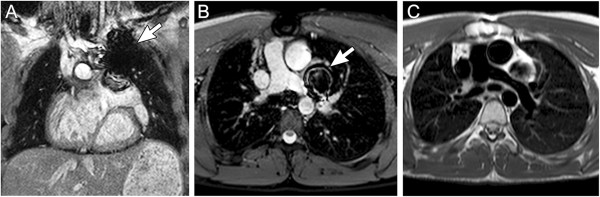
Stainless steel coil artifact. 17-year-old patient with dextrocardia, double-outlet right ventricle, and pulmonary stenosis who has undergone a Rastelli operation and catheter implantation of a single stainless steel vascular coil to occlude a small left superior vena cava draining to the left atrium. ECG-gated steady-state free precession sequence in a coronal plane (A) and axial plane (B) demonstrating a region of signal loss in the upper left chest (arrow) resulting from the coil. The area of signal loss is several times larger than the coil and obscures a portion of the left pulmonary artery. (C) shows an ECG-triggered fast spin echo sequence with a double inversion preparation pulse acquired in diastole with a similar orientation as in (B) With this sequence, the extent of signal loss artifact is reduced, and the left pulmonary artery is more clearly visualized.